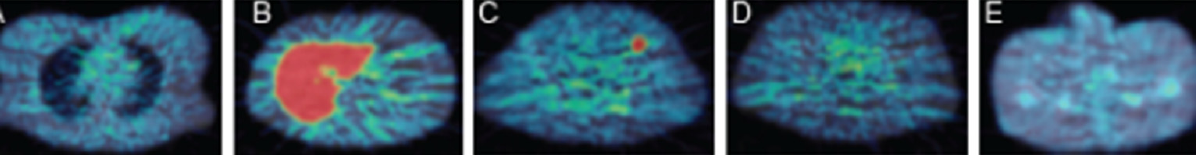
Figure 2. Effects of menstrual cycle on ovarian accumulation of [ 11 C]vorozole, an aromatase inhibi- tor. Pseudocolored (rainbow spectrum) examples of 11 C-vorozole uptake. axial images ( A – E ) were